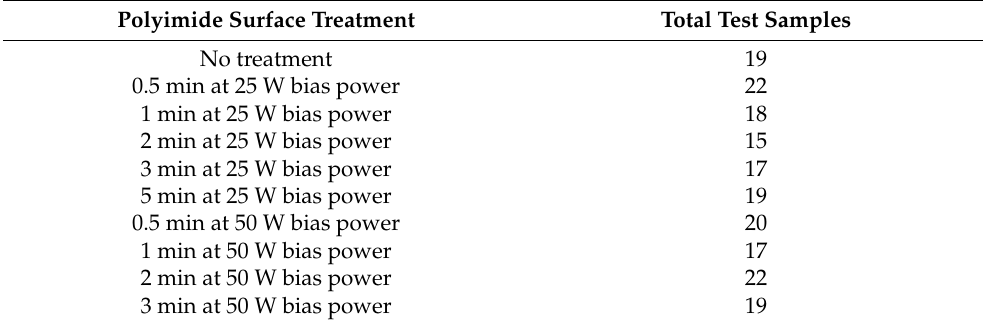
Table 1. Overview of the number of test samples used for the analysis of the long-term stability.